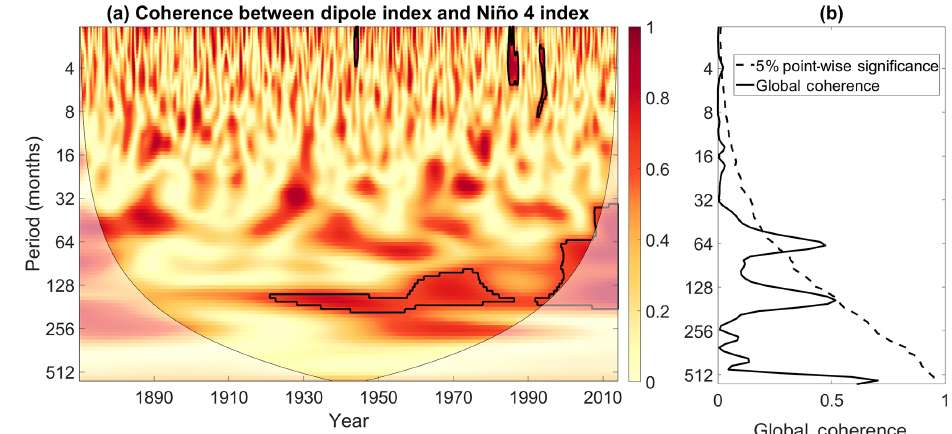
Figure 13. (a) Wavelet coherence between the dipole and Niño 4 indices. Contours enclose regions of 5% cumulative area-wise significance. (b) The global coherence spectrum corresponding to (a) . Dotted line is the 5% point-wise significance bound and the red curves indicate 5% arc-wise significant coherence values.